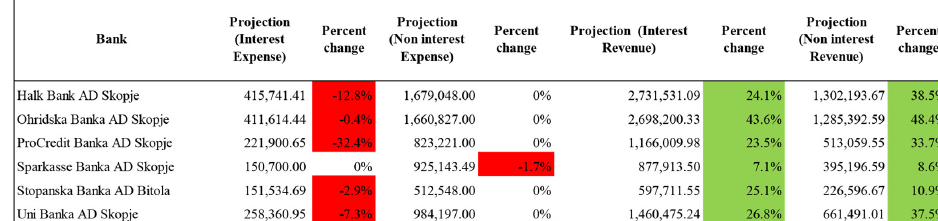
12 of 22 Figure 3. Croatian commercial banking efficiency results.